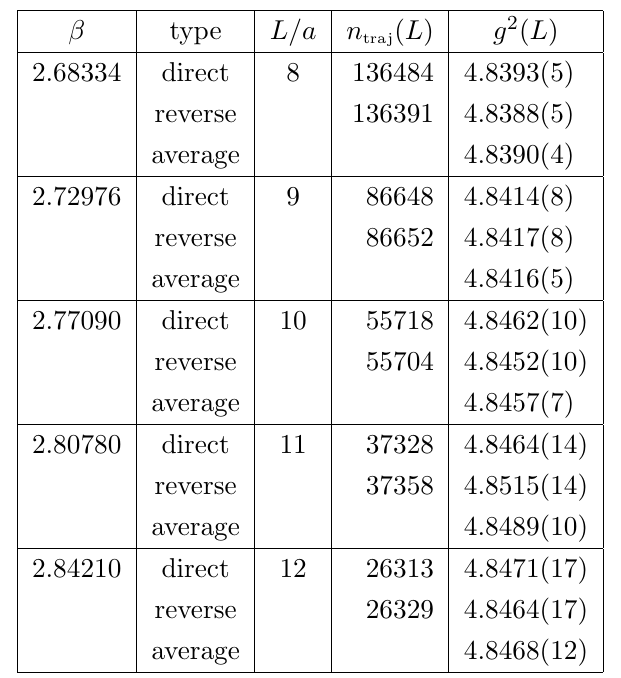
Table 5 . Results from the set of simulations on the lattices of the largest physical size (correspond- ing to g 2 ’ 4 : 85(4)) from direct and reverse transformations with (cid:1) (cid:17) = 0 : 0001 and n and their average, in SU(2) Yang-Mills theory.